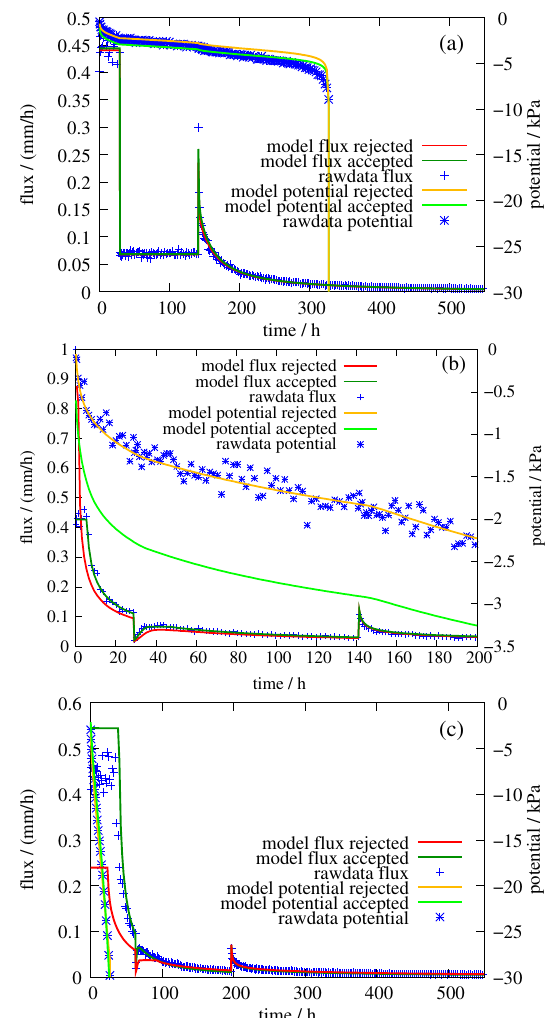
Fig. 15. Comparison between the accepted fits with the largest residuum and the rejected fits with the lowest residuum, for sand (a) (residuum 4900 (accepted) vs. 9700 (rejected)), loamy sand (b) (residuum 28000 vs. 3300), and silt (c) (residuum 4600 vs. 7300), respectively. The reason for rejecting the curves were for (a) the deviation of the tensiometer, for (b) the first plateau was not repre- sented, and for (c) the first peak was not represented, respectively. Note that for (b) , although the potential of the accepted fit matches worse than in the accepted one, its deviation is just at the sort-out limit and limit cases were still accepted, while the plateau in the rejected fit is definitely not represented at